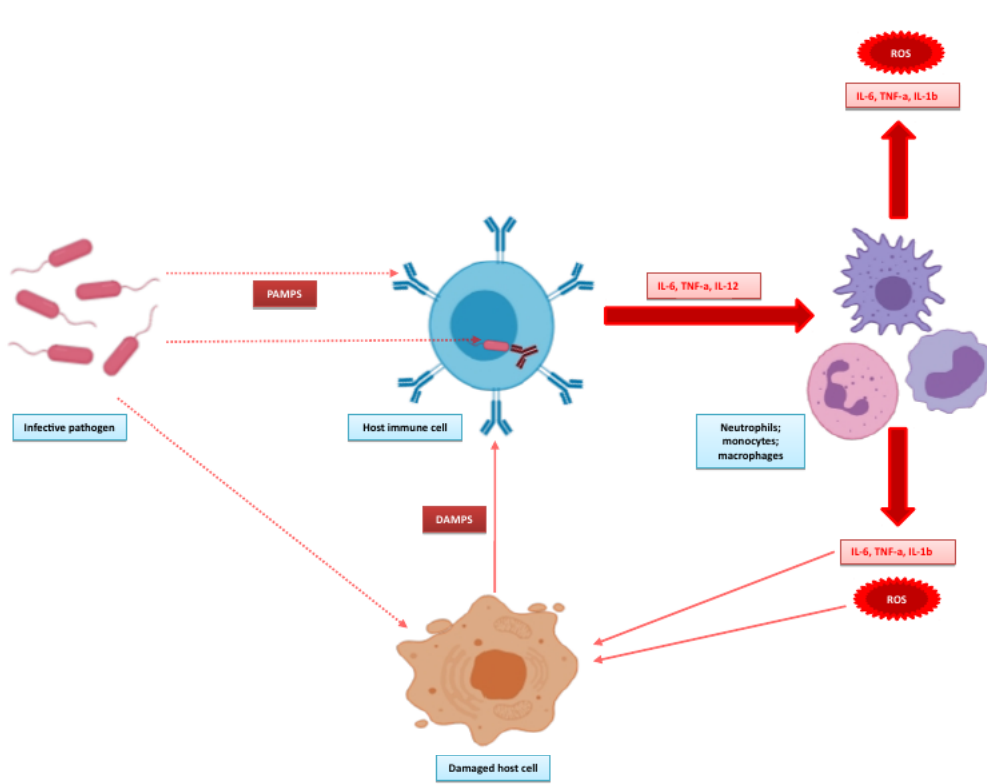
Figure 2. Pro-inflammatory cascade in sepsis (adapted from the works of Angus and van der Poll [30] and Wiersinga and co-workers [31]. Infective agents release pattern associated molecular patterns (PAMPS) which are recognised by host immune cells via pattern recognition receptors both extra- and intracellularly. These cells also recognise damage-associated molecular patterns (DAMPS) released by damaged host cells. In response, the immune cells release inflammatory cytokines, activating leucocytes which in turn release cytokines and reactive oxygen species, further promoting the inflammatory response, which can affect host cells as well as the invading pathogen.